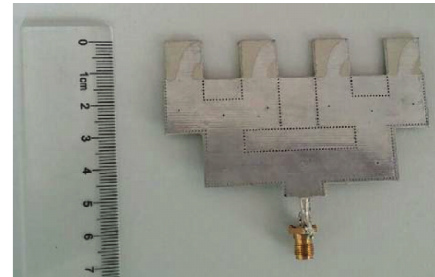
Figure 20: Fabricated antipodal SIW Vivaldi antenna